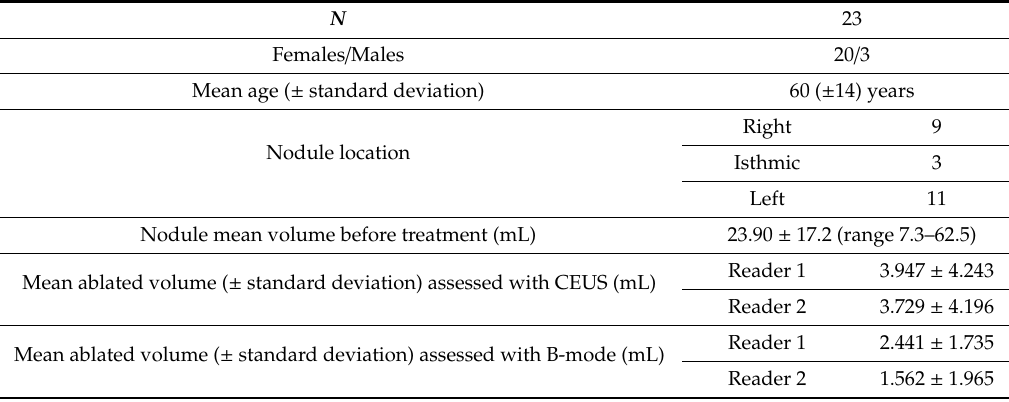
Table 1. Patient and nodule characteristics.